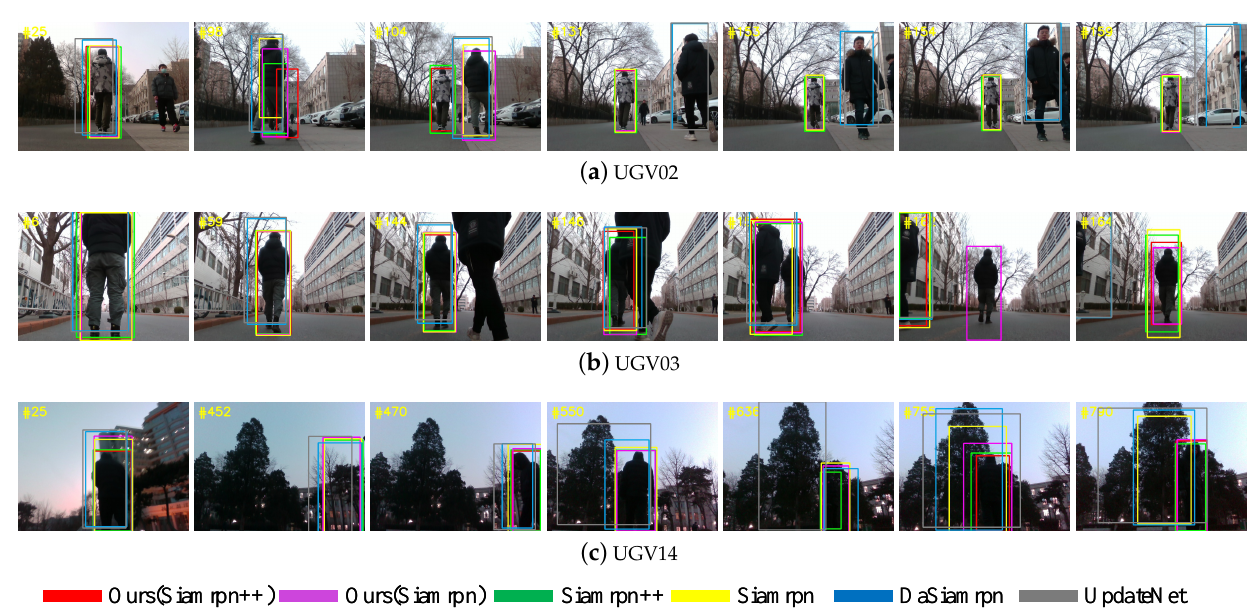
Figure 6. Qualitative results of short-term